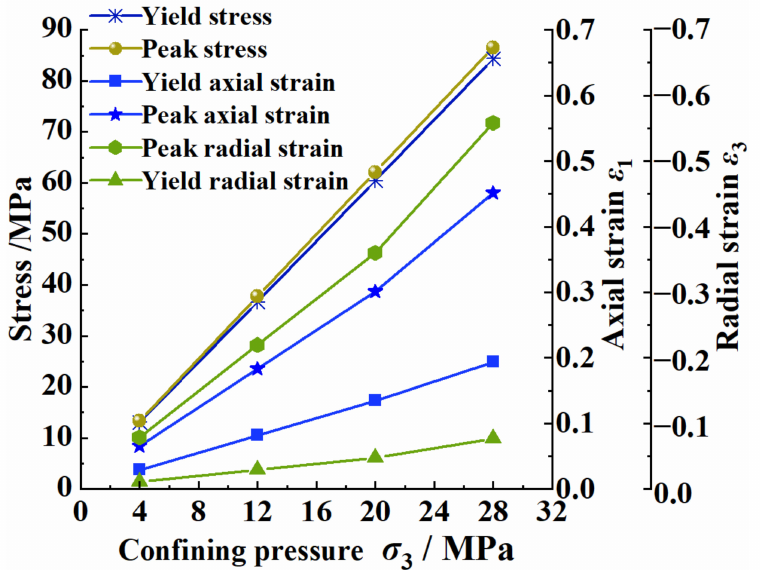
Figure 4. Stress and strain changes corresponding to yield and peak points under different confining